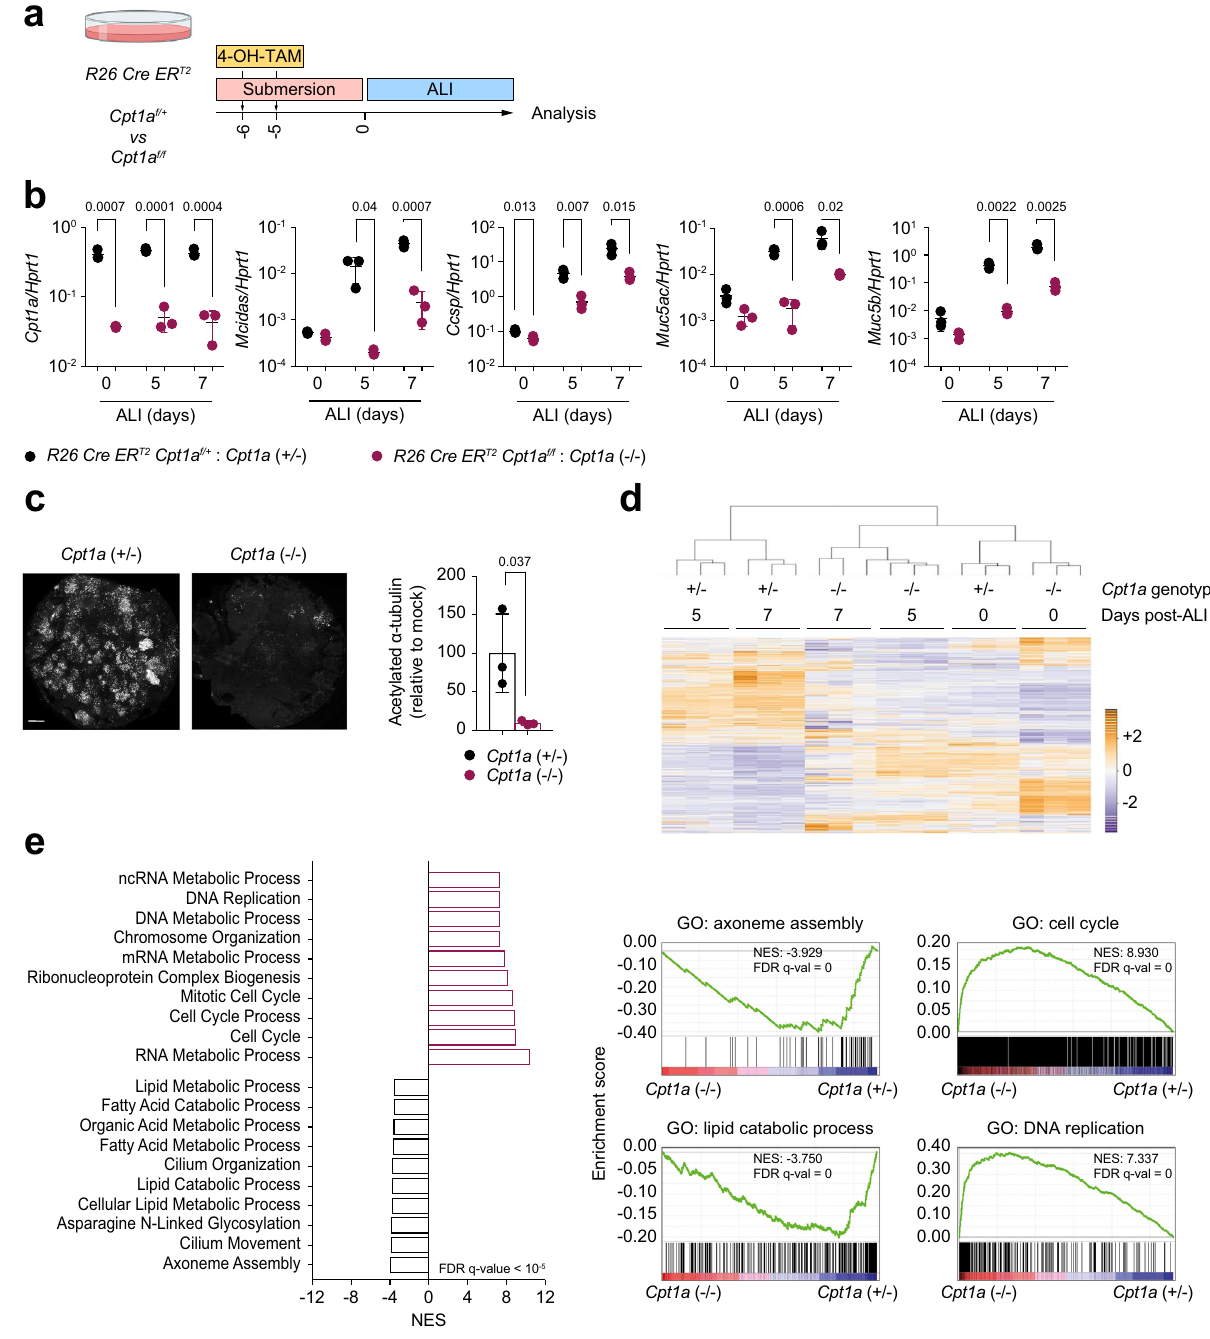
Fig. 3 | Cpt1a deletion prevents airway epithelial cell differentiation. a Scheme representing the experimental strategy used throughout this fi gure. R26 CreERT2 Cpt1a f/f and R26 CreERT2 Cpt1a f/+ mTEC cultures were treated with 4-hydroxytamoxifen (4-OH-TAM) for two days during the proliferation phase to induce Cre recombinase activity. Cultures were analysed at ALI day 0, 5 and 7. b qPCR analysis of mRNA expression levels of the indicated genes in Cpt1a +/ − and Cpt1a − / − mTEC cultures at ALI day 0, 5 and 7. Values are normalized to Hprt1 expression. Data show mean+/ − SD. Statistics were performed using multiple unpaired t tests and adjusted using the Holm – Sidak correction. n =3 biologically independent samples. c Fluorescence microscopy analysis and quanti fi cation of